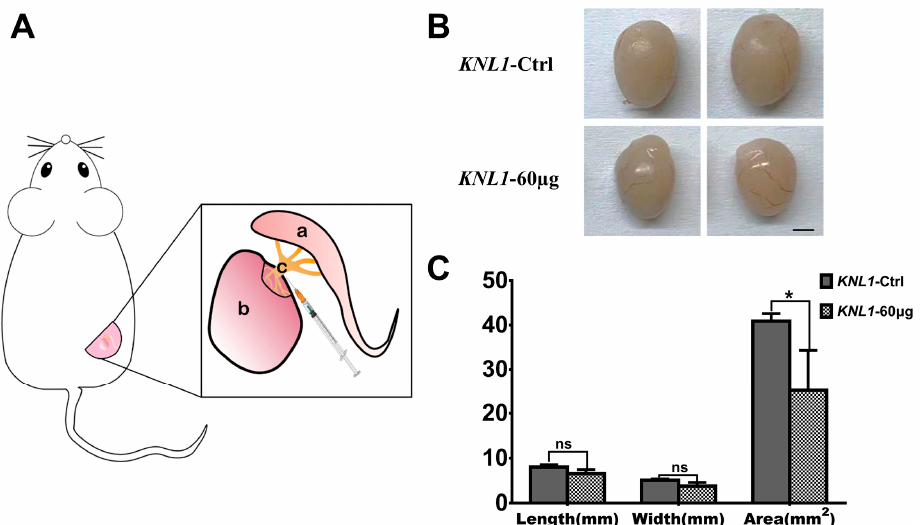
Figure 2. Operation diagram and the loss-function of KNL1 to the testicle phenotype. ( A ) Surgical